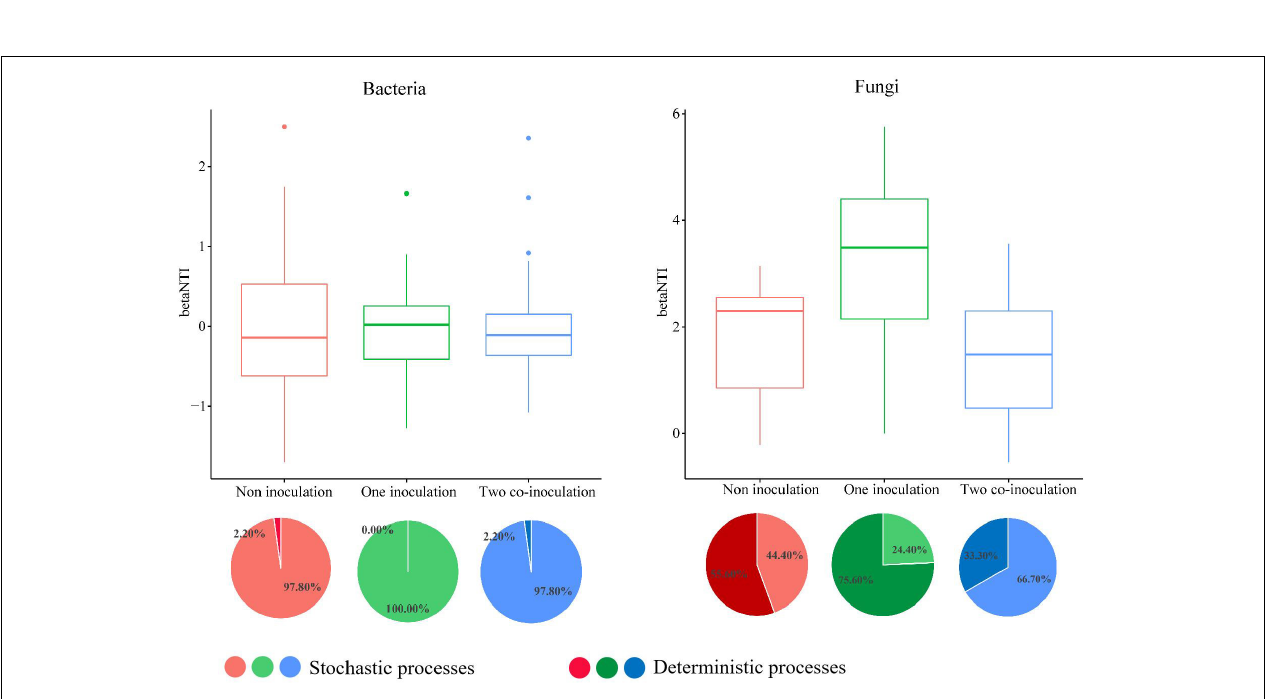
FIGURE 6 | The community assembly processes by fitting niche-based theories. The relationship between inoculation of Bradyrhizobium japonicum 5038 and Bacillus aryabhattai MB35-5 and betaNTI. The top 50 and 100 abundance OTU were chose for constructing phylogenetic tree. Pie plots showing the relative contribution of each ecological process in community assembly response along the inoculation of Bradyrhizobium japonicum 5038 and Bacillus aryabhattai MB35-5.unity model of community assembly.